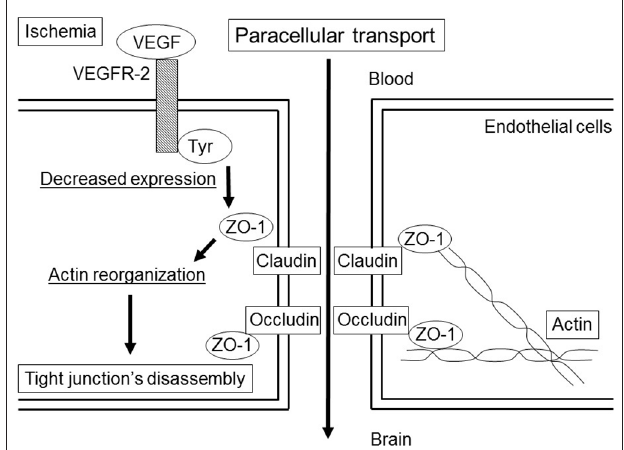
FIGURE 1 | Paracellular transport in the blood-brain barrier (BBB) by the vascular endothelial growth factor (VEGF) under ischemic condition. The binding of VEGF to the VEGF receptor-2 (VEGFR-2) induces the activation of tyrosine kinase (Tyr), which leads to a decrease in the expression of zonula occludens (ZO)-1. The changes in ZO-1 correlate with small changes in action distribution, which induce disassembly of the tight junction